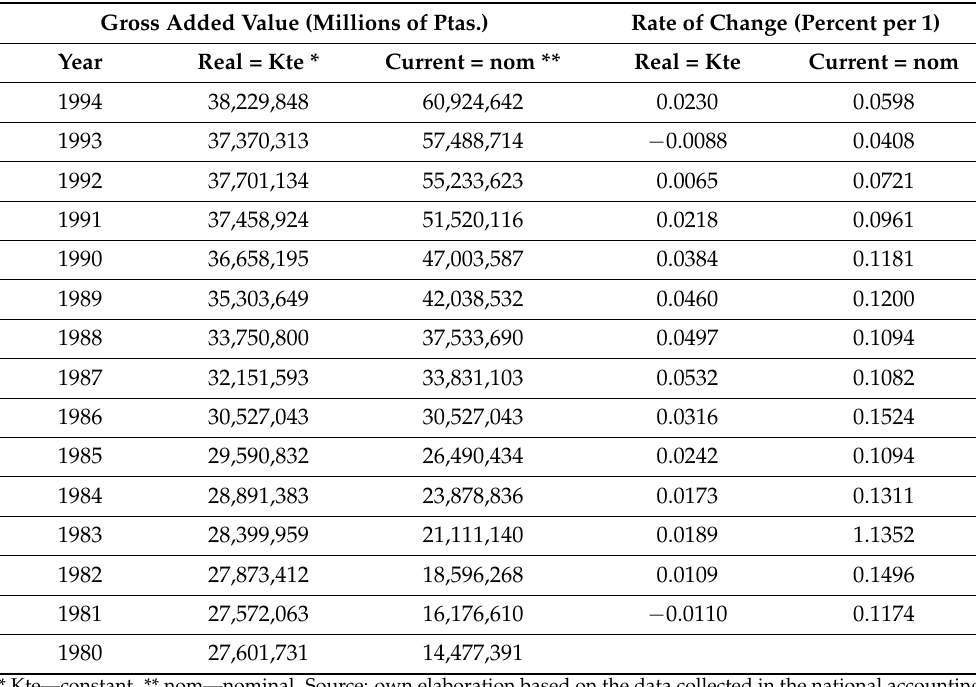
Table 5. Gross value added at market prices and rate of change. Total branches of activity. Gross Added Value (Millions of